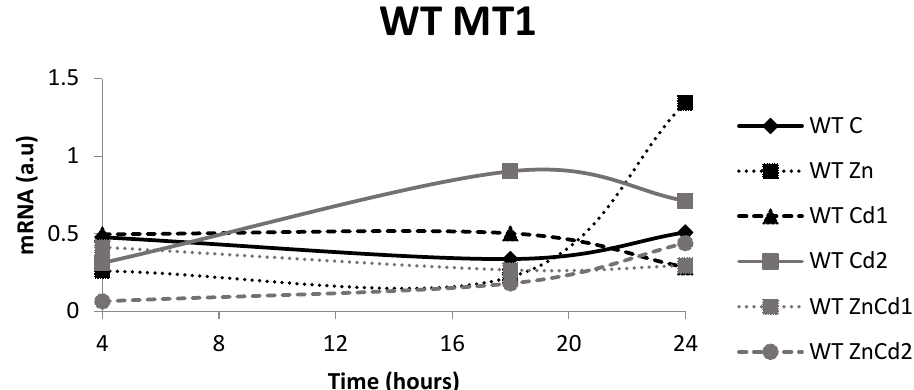
Figure 6. mRNA in arbitrary units (a.u.) of the MT-1 gene in the WT strain. C = Control; Zn = Zn 50 µM; Cd 1 = Cd 1 µM; Cd 2 = Cd 2 µM; ZnCd 1 = Zn 50 µM + Cd 1 µM; ZnCd 2 = Zn 50 µM + Cd 2 µM.